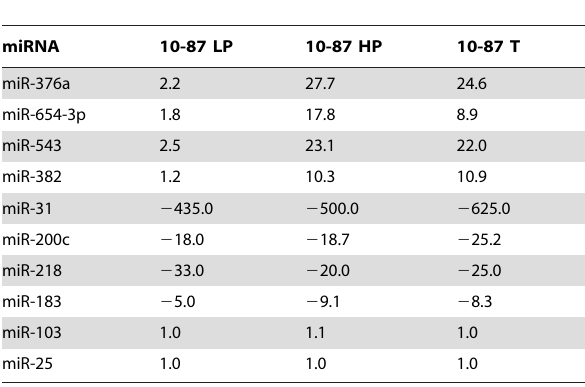
Table 3. Validation of the differential expression of selected miRNA in 10-87 VERO cells using Taqman quantitative RT- PCR 1